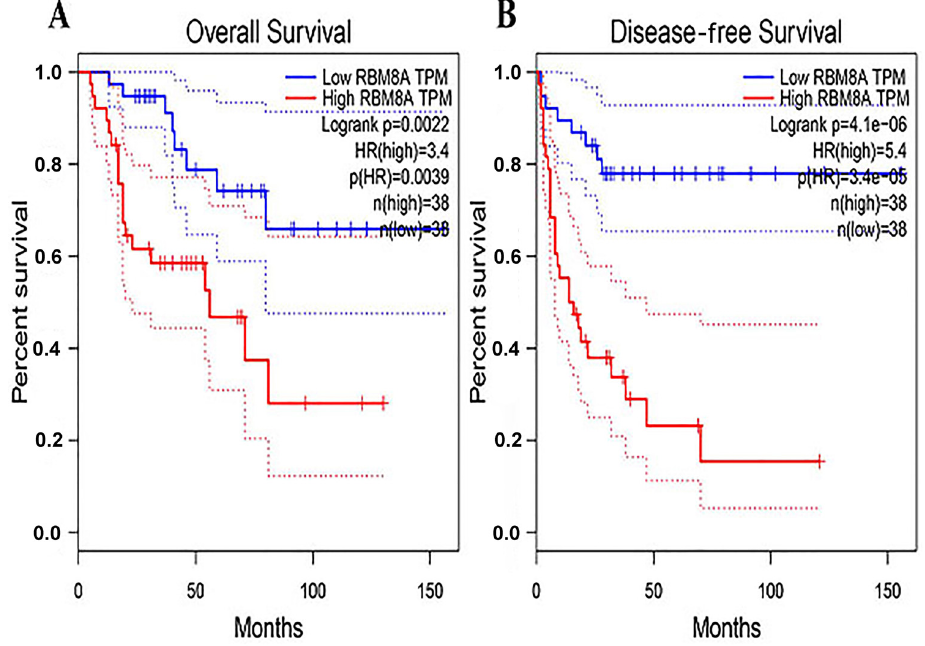
Figure 5. Relationship between the level of RBM8A and overall survival ( A ) and disease-free survival ( B ) in patients with gastric